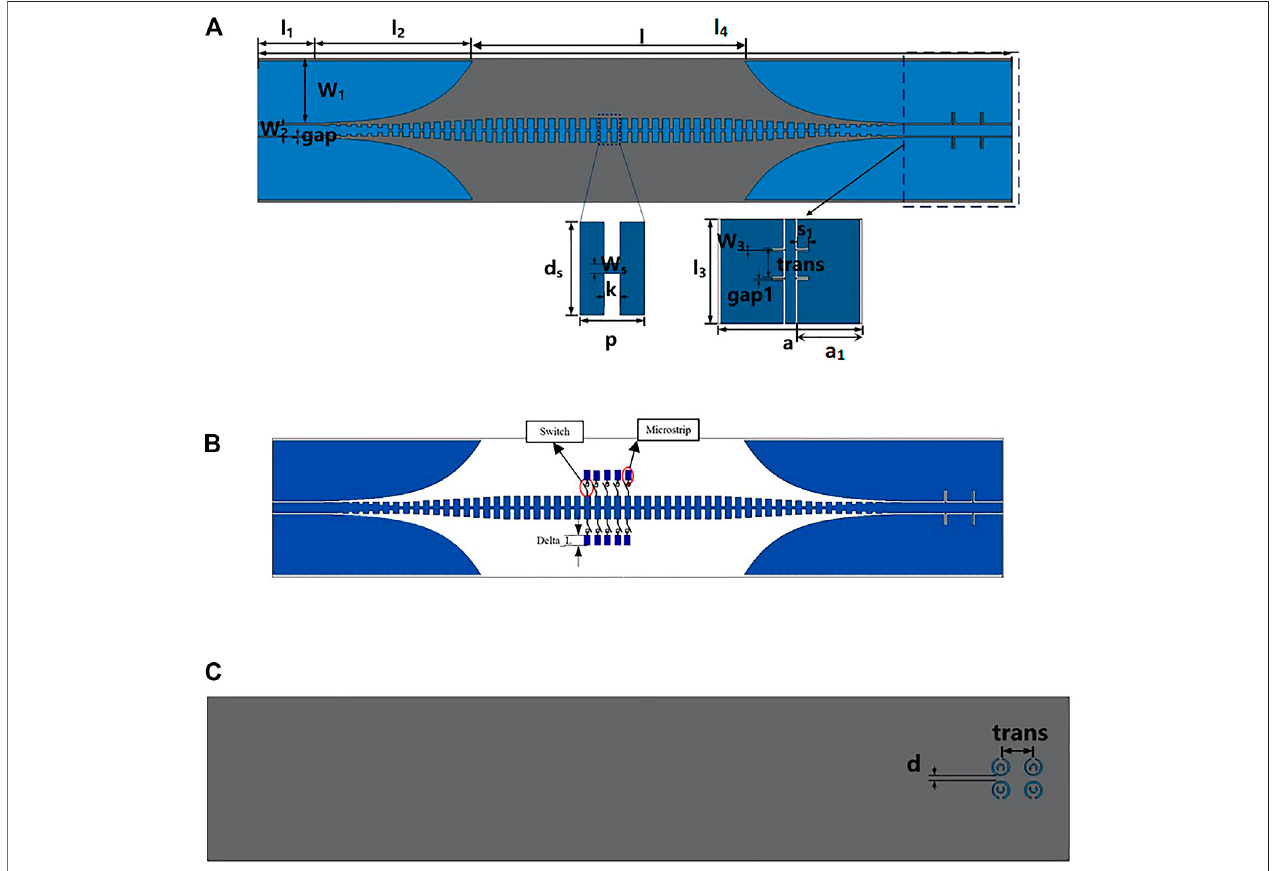
FIGURE1|(A) thefrontviewofthespoofsurfaceplasmon fi lter, (B) thefrontviewofthespoofsurfaceplasmon fi lterusingdioderecon fi gurabletechnology,and (C) the back view of the spoof surface plasmon fi lter.